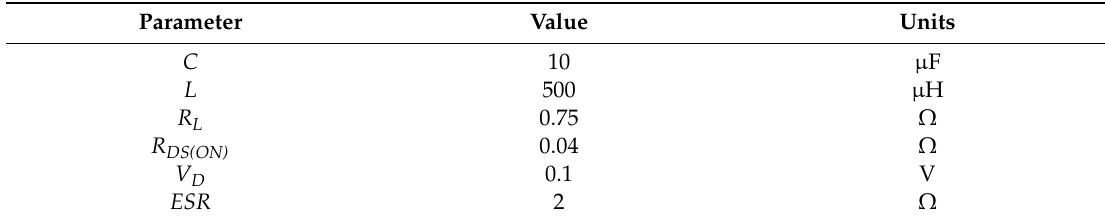
Table 6. Buck converter measured parameters.